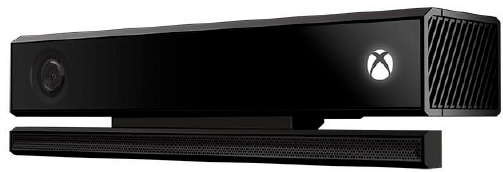
Figure 6. Microsoft Kinect v2 sensor (Microsoft Corp., Redmond, WA, USA).